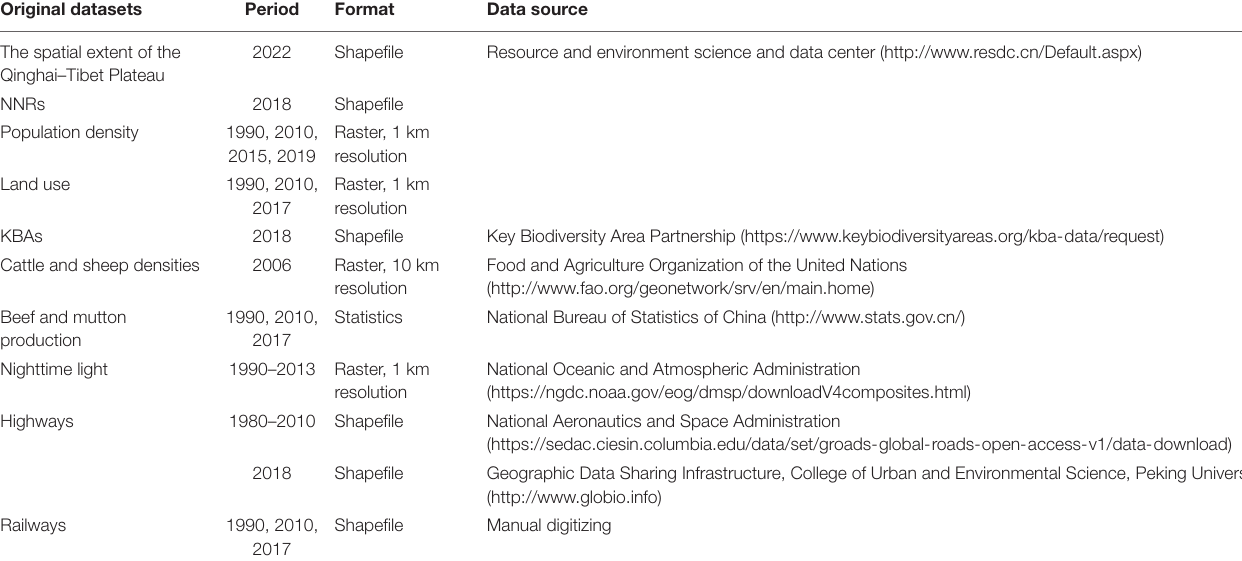
TABLE 2 | Datasets used in this